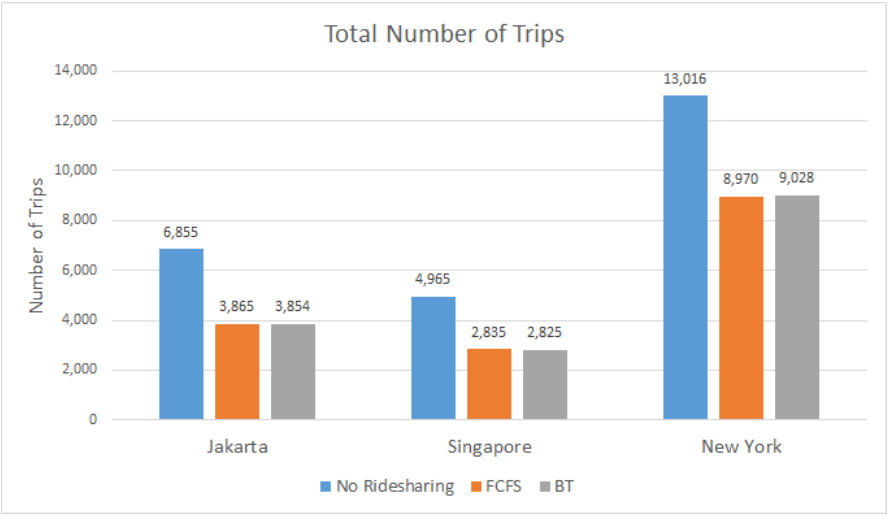
Figure 5. Number of Feasible Ridesharing Passengers